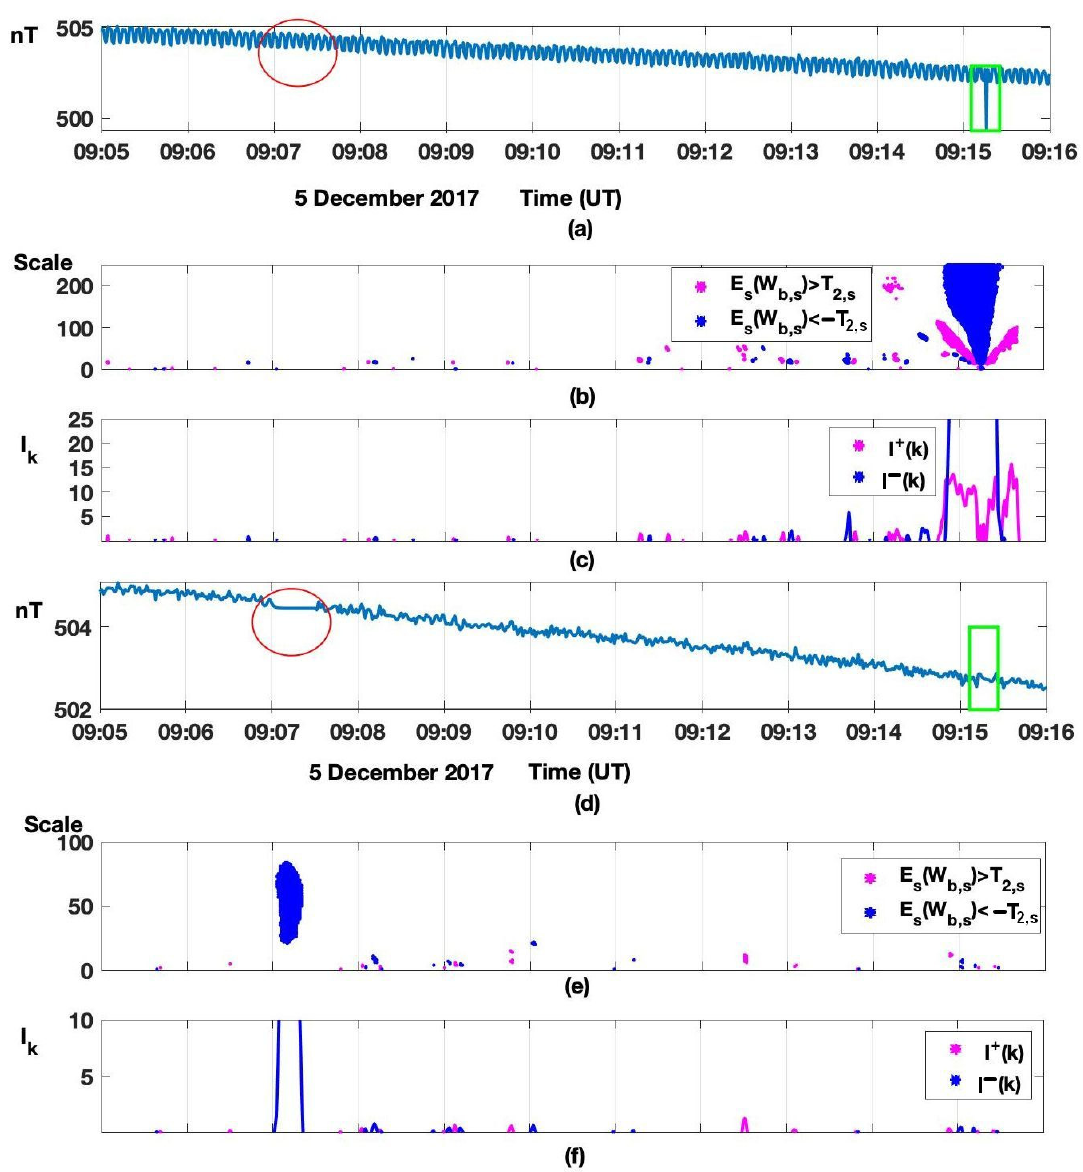
Figure 7. Processing results for H-component variations on 5 December 2017. ( a ) H-component, noisy; ( d ) H-component, cleared; ( b , c , e , f ) results of method